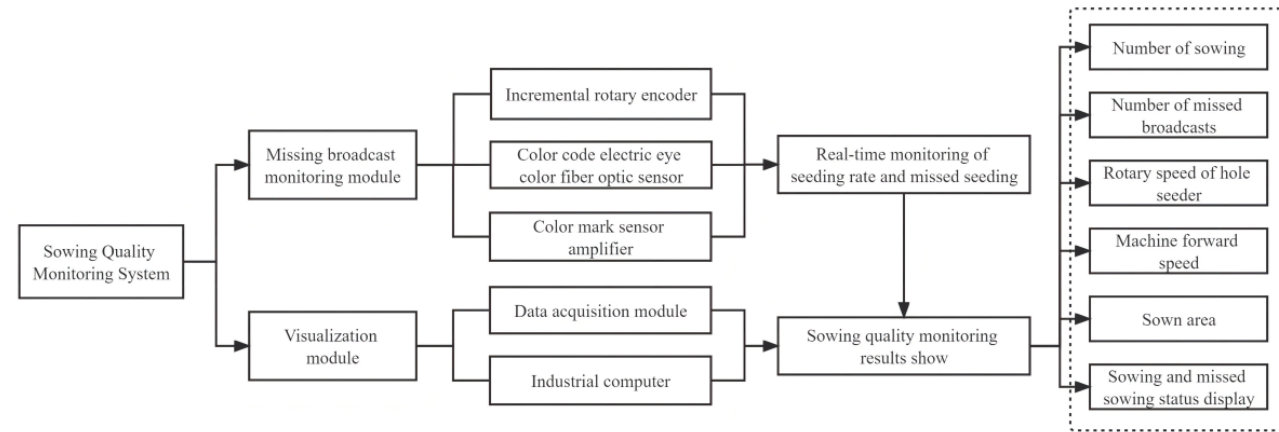
Figure 2. Structural diagram of monitoring system.